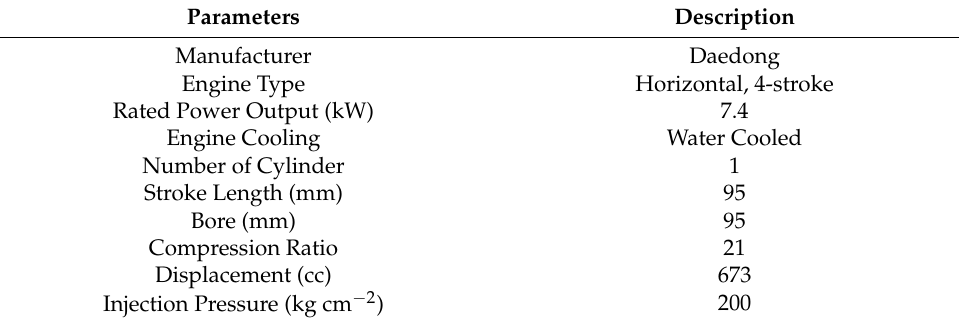
Figure 1. Experimental setup. Table 3. Engine specification.